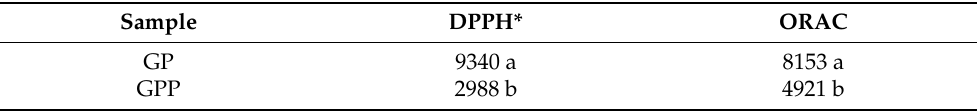
Table 3. Antioxidant capacity (DPPH* and ORAC) of grape pomace and grape pomace powder (GPP) from Tintorera